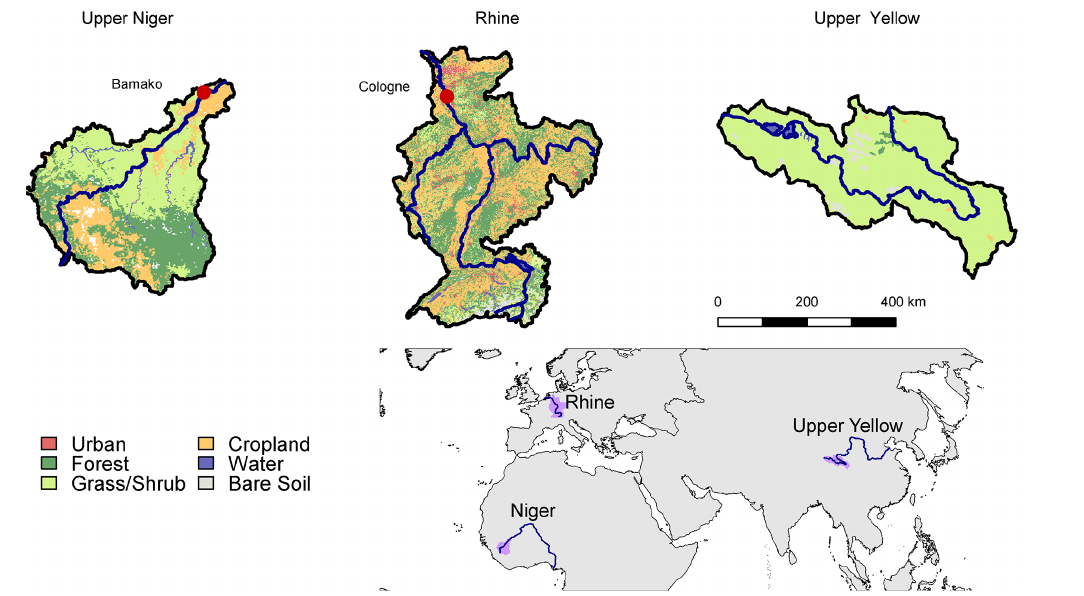
Figure 1. Land-use maps of the three basins under study: the Upper Niger, the Rhine and the Upper